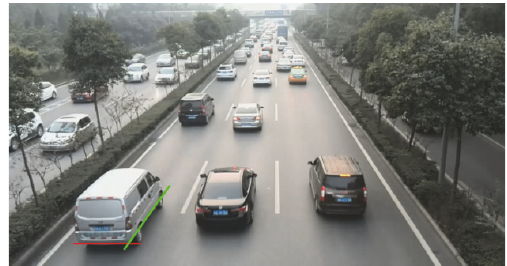
Figure 30: Extraction results of the chassis